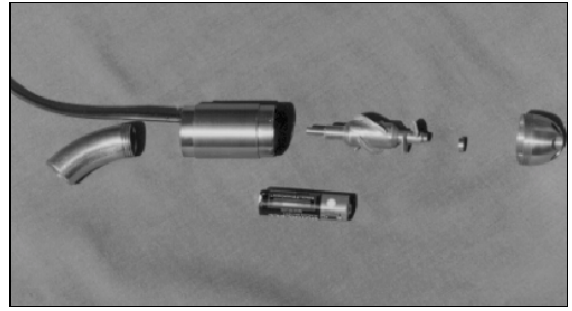
Fig. 2 - Dispositivo desmontado demonstrando a simplicidade do